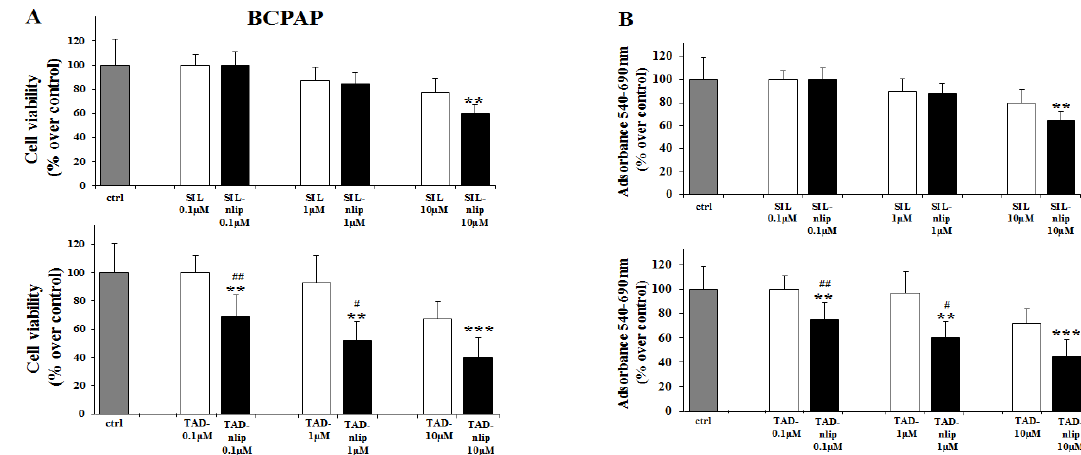
Figure 3. Nanoliposomes containing PDE5 inhibitors reduced proliferation of TPC-1 cells. After 24 h of treatment, proliferation was evaluated by cell count assay ( A ) and MTT assay ( B ), as described in Materials and Methods. Results are mean ˘ SD of three experiments performed in triplicate. *, **, ***, p < 0.05, 0.01, 0.001 vs. control (ctrl); ˝ , ˝˝ , ˝˝˝ , SIL-nlip vs SIL; # , ## , ### , p < 0.05, 0.01, 0.001 TAD-nlip vs. TAD.